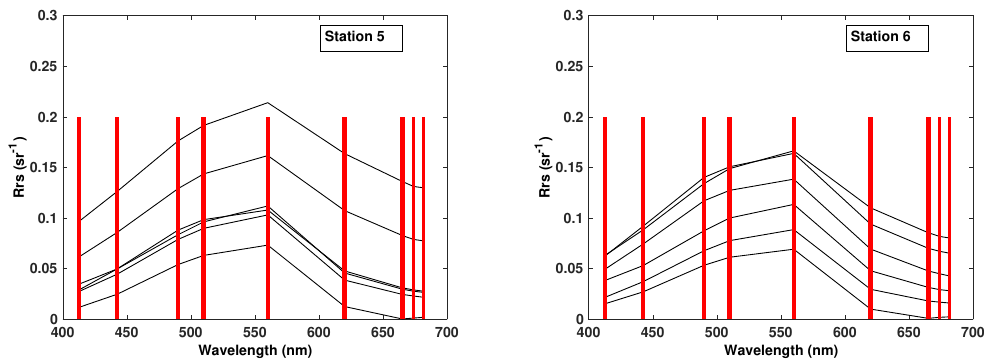
Figure 3. S3 retrieved Rrs values for the 9 spectral bands at the 6 stations. The red bars indicate the position of the bands, and their widths illustrate the relative proportion of the width of the